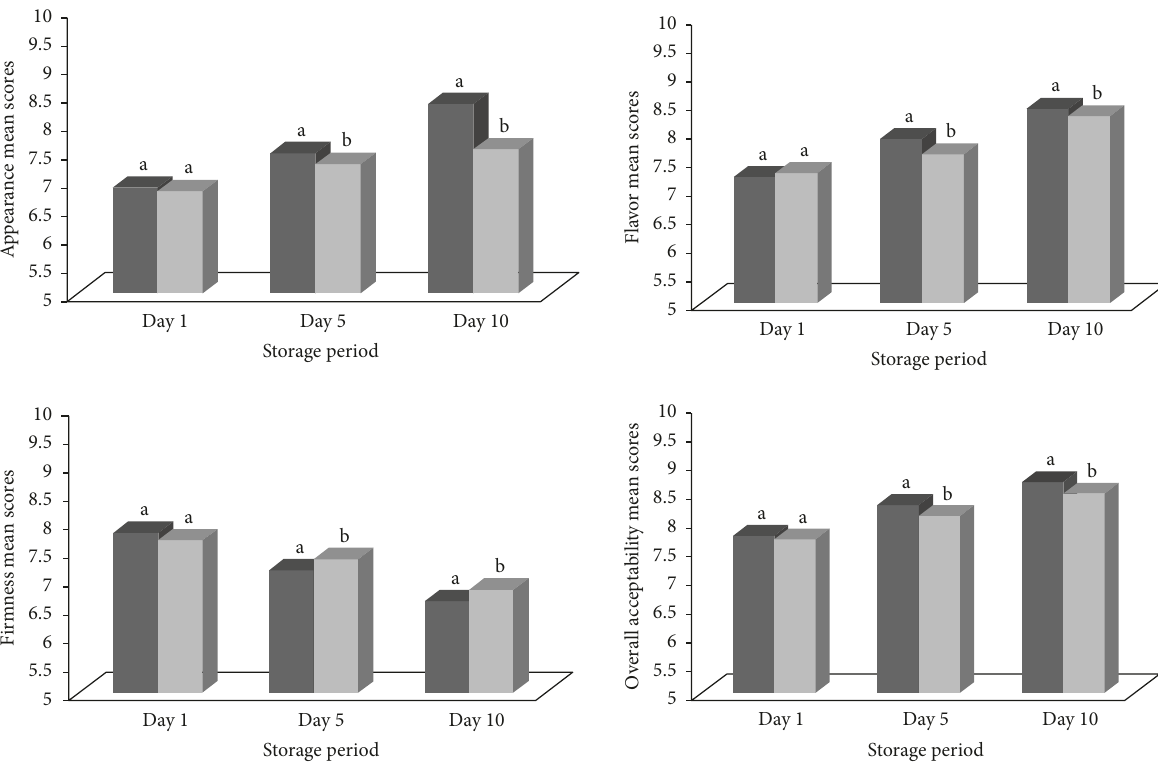
Figure 7: Sensory evaluation of uncoated (dark gray) and coated (light gray) tomatoes stored at 22 ± 2 ∘ C for 10 days. Scores designated by differentlettersaresignificantlydifferent( 𝑝 ≤ 0.05 )foreachattribute.Threedifferenttrialswerecarriedoutintriplicate.Thescalecorresponds to 9 = excellent and 1 = extremely